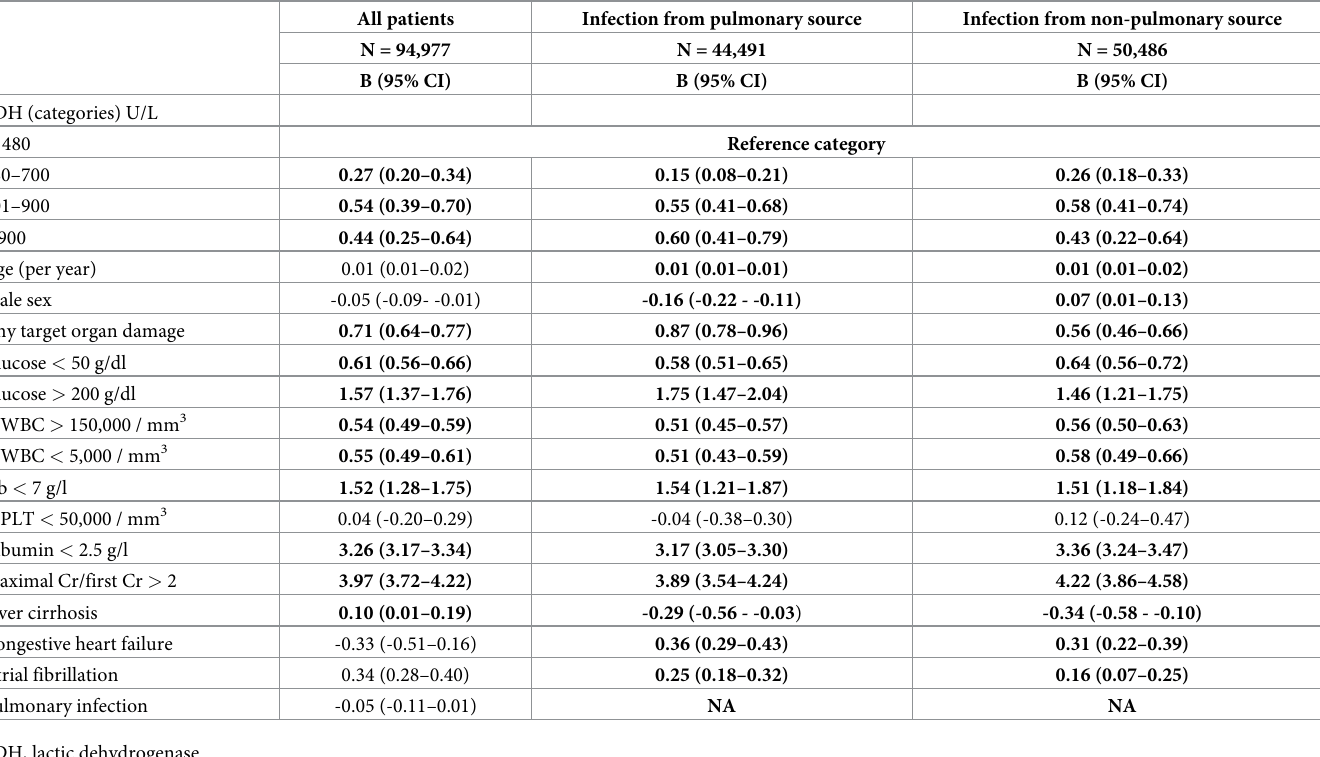
Table 4. Factors associated with median length of stay (multivariable quantile